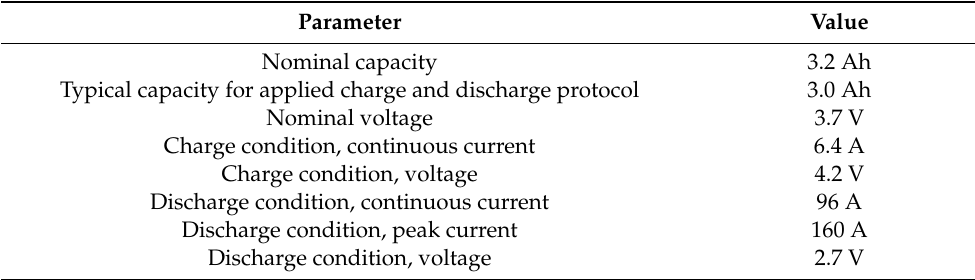
Table 1. Cell specifications of SLPB